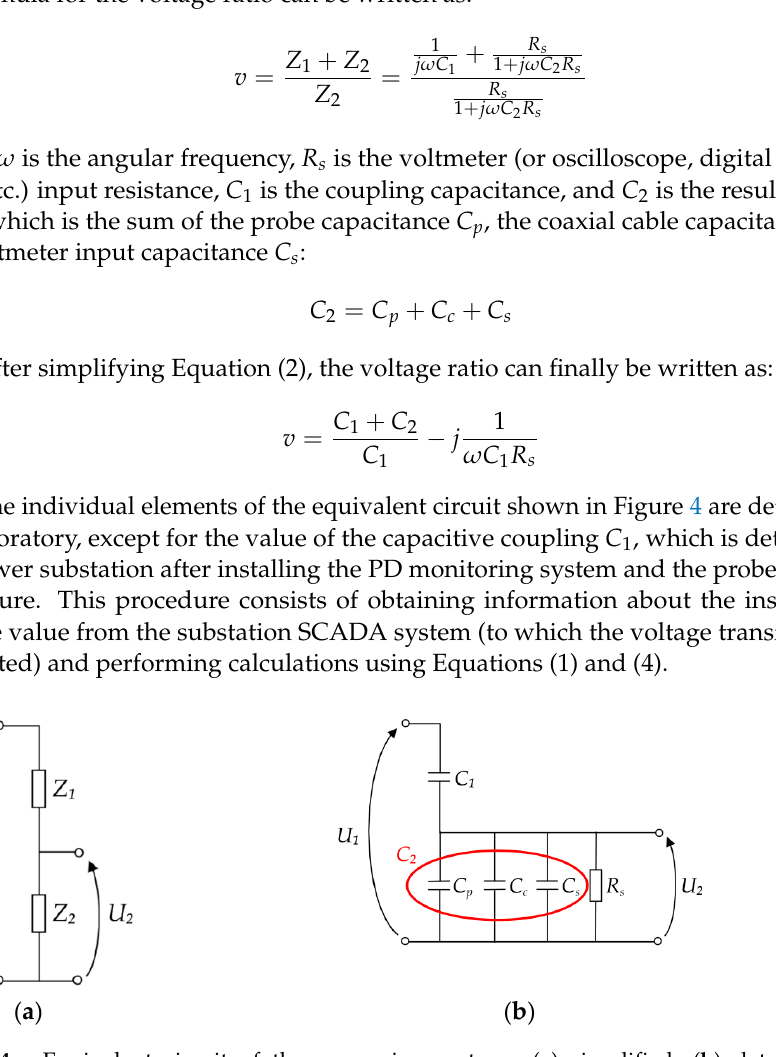
Figure 4. Equivalent circuit of the measuring system: ( a ) simplified, ( b ) detailed, where: C 1 —cou- pling capacitance between the probe and the tested object, C p —probe capacitance, C c —coaxial cable capacitance, C s —voltmeter input capacitance, and R s —voltmeter